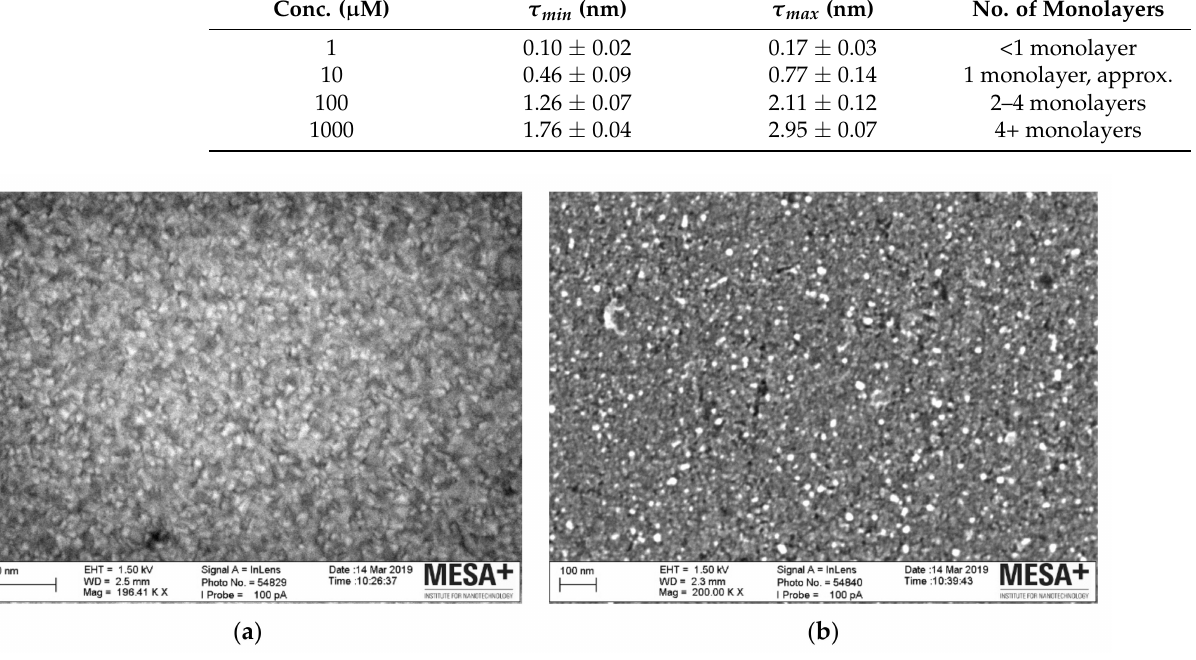
Figure 1. SEM micrographs of the ( a ) uncoated Pt surface and ( b ) Cr x O y H z -coated Pt surface produced from electrolyte containing 5 mM Na 2 Cr 2 O 7 /0.1M